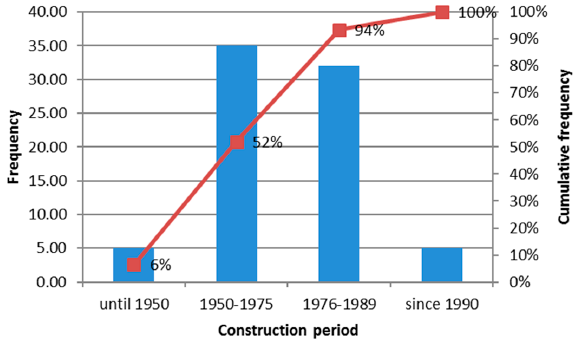
Figure 3. Frequency distribution of schools in terms of construction period.